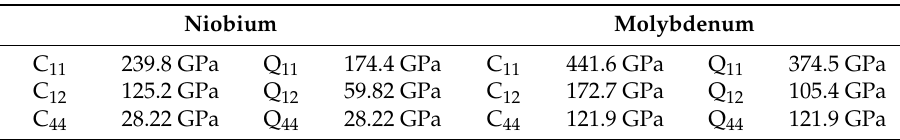
Table 1. Material properties of niobium and molybdenum.